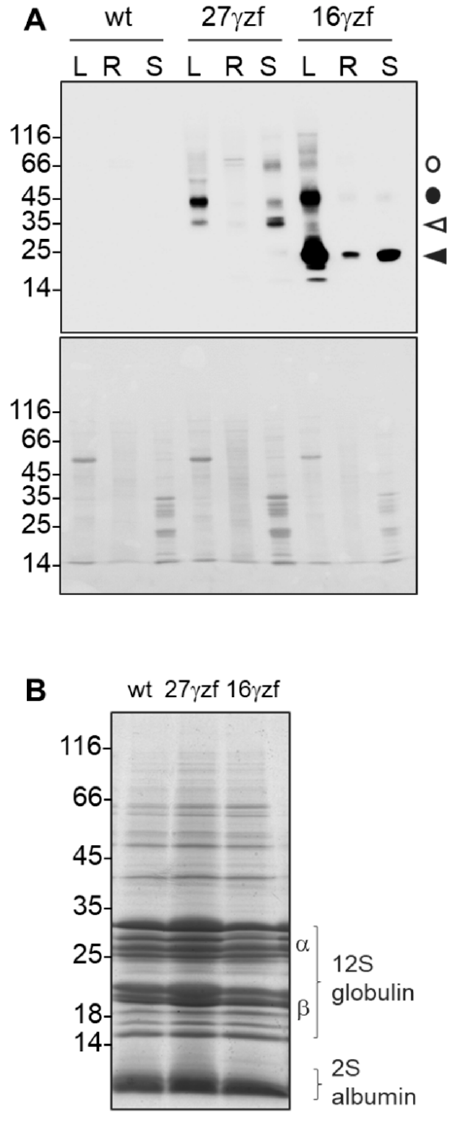
Figure 1. 27 γ zf and 16 γ zf accumulate in dry seeds and do not interfere with the sorting of endogenous Arabidopsis storage proteins. ( A ): Total protein homogenates were prepared with denaturing buffer from leaves (L), roots (R), or dry seeds (S) of Arabidopsis constitutively expressing FLAG-tagged versions (f) of 27 γ z or 16 γ z, or from wild-type (wt) plants. Top panel: Analysis by SDS-PAGE and protein blot with anti-FLAG antibodies. The position of 27 γ zf (empty arrowhead), 16 γ zf (black arrowhead) monomers and their respective dimeric forms (empty and black circles, respectively) are indicated. Bottom panel: total proteins staining with Ponceau S. ( B ): Analysis of total protein extracts from dry seed by SDS-PAGE and Coomassie blue staining. The positions of the mature polypeptides of the endogenous 12S globulins and 2S albumins are indicated. Numbers on the left in both A and B indicate the position and size (kDa) of molecular mass markers.